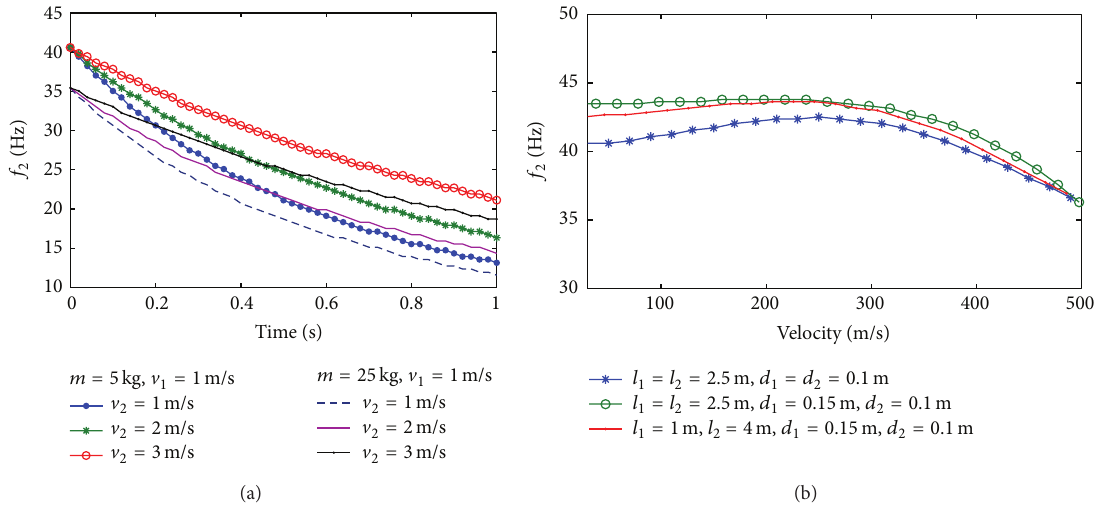
Figure 4: (a) Different V , 2 same segments, 𝑓 2 ; (b) different 𝐿 , 𝑆 , 2 segments, 𝑚 = 5 kg, 𝑓 2